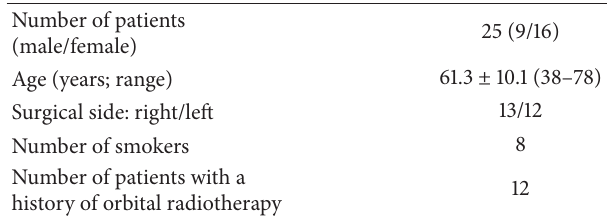
Table 1: Patient data.